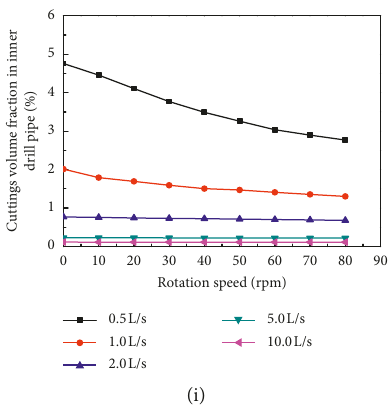
Figure 9: Volume fractions of cuttings with different diameter at the bottom of the drill tool under different rotational speeds: (a) well deviation angle is 90 degrees and cuttings diameter is 2mm, (b) well deviation angle is 90 degrees and cuttings diameter is 6mm, (c) well deviation angle is 90 degrees and cuttings diameter is 10mm, (d) well deviation angle is 80 degrees and cuttings diameter is 2mm, (e) well deviation angle is 80 degrees and cuttings diameter is 6mm, (f) well deviation angle is 80 degrees and cuttings diameter is 10mm, (g) well deviation angle is 70 degrees and cuttings diameter is 2mm, (h) well deviation angle is 70 degrees and cuttings diameter is 6mm, and (i) well deviation angle is 70 degrees and cuttings diameter is 10mm.